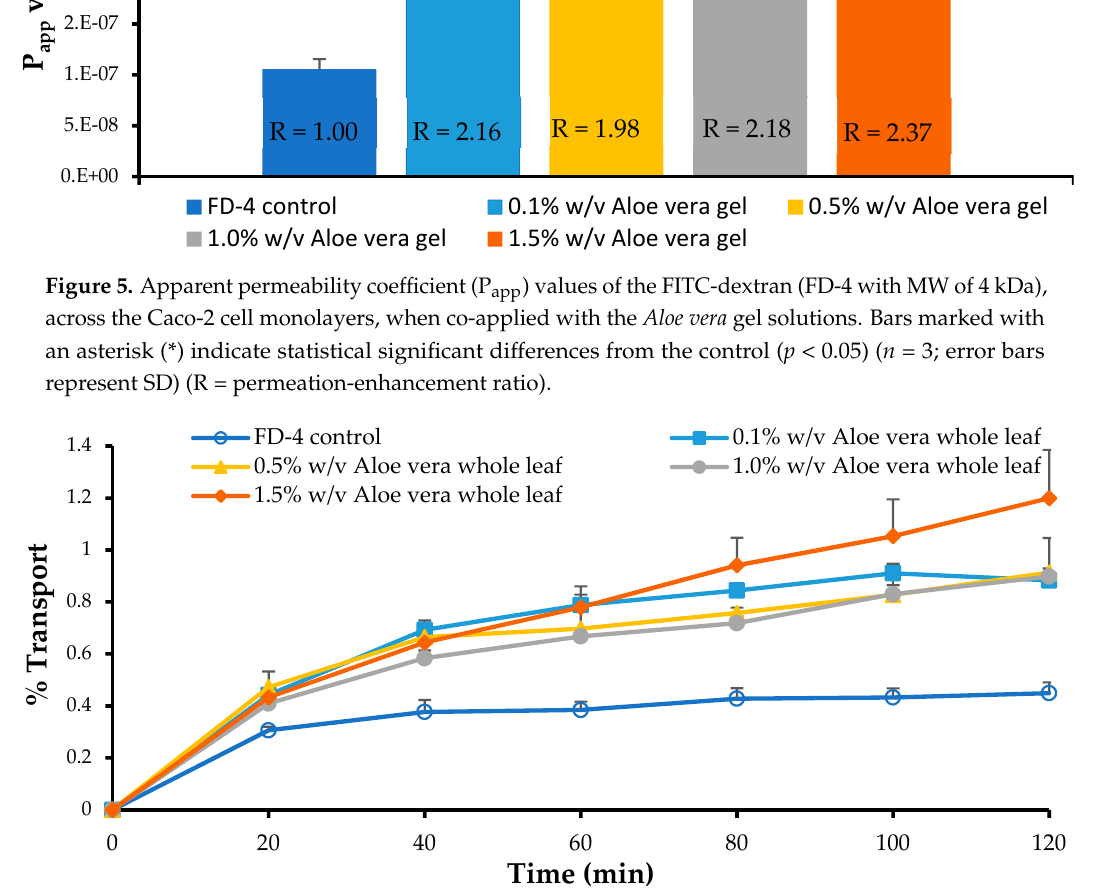
Figure 6. Percentage transport of the FITC-dextran (FD-4 with MW of 4 kDa) plotted as a function of time, across the Caco-2 cell monolayers, in the absence (FD-4 control) and presence of the Aloe vera whole-leaf extract solutions, with different concentrations ( n = 3; error bars represent SD).